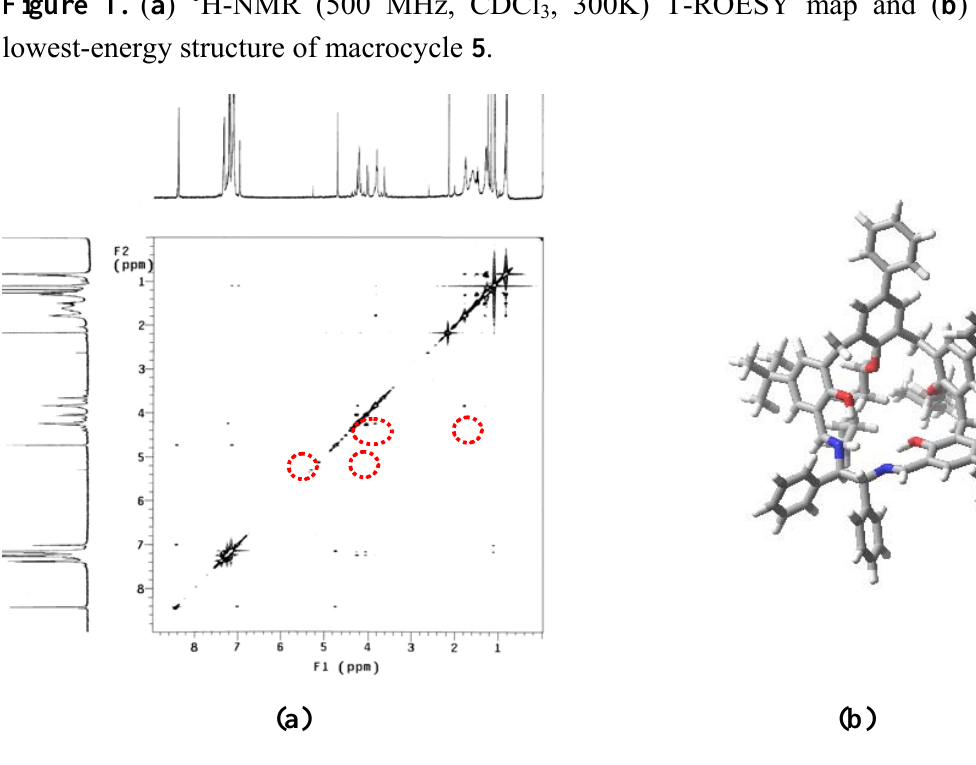
Figure 1. ( a ) 1 H-NMR (500 MHz, CDCl